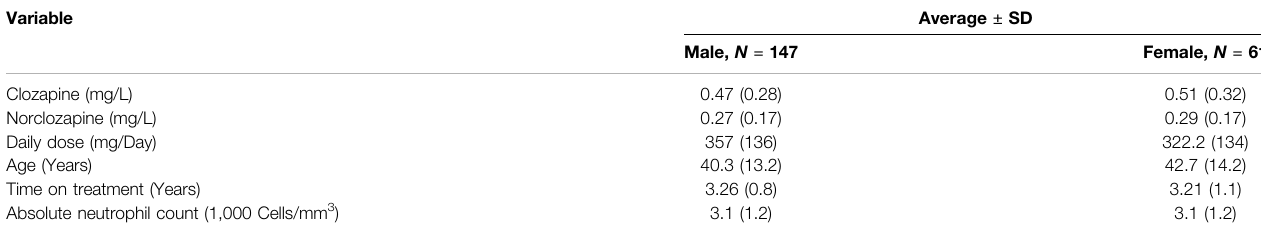
TABLE 2 | Covariates used in the correlation and regression analyses, and their distribution in the CLOZUK2 sample described in this study. Variable